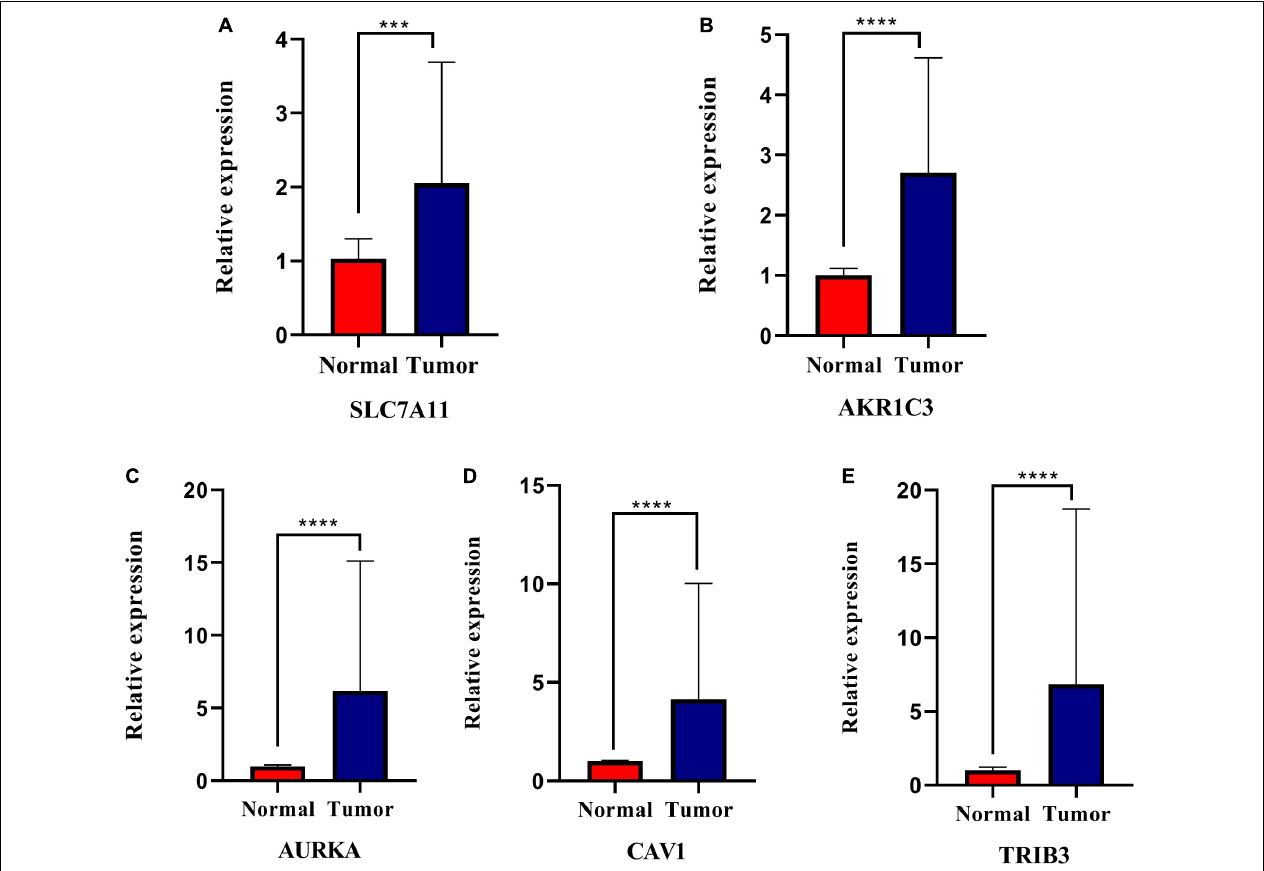
FIGURE 10 | Relative expression levels of the five genes in normal and squamous cell carcinoma of the head and neck tissues (HNSCC). SLC7A11 (A) , AKR1C3 (B) , AURKA (C) , CAV1 (D) , and TRIB3 (E) are significantly up-regulated in HNSCC tissues. * P < 0.05; ** P < 0.01; *** P < 0.001; **** P <